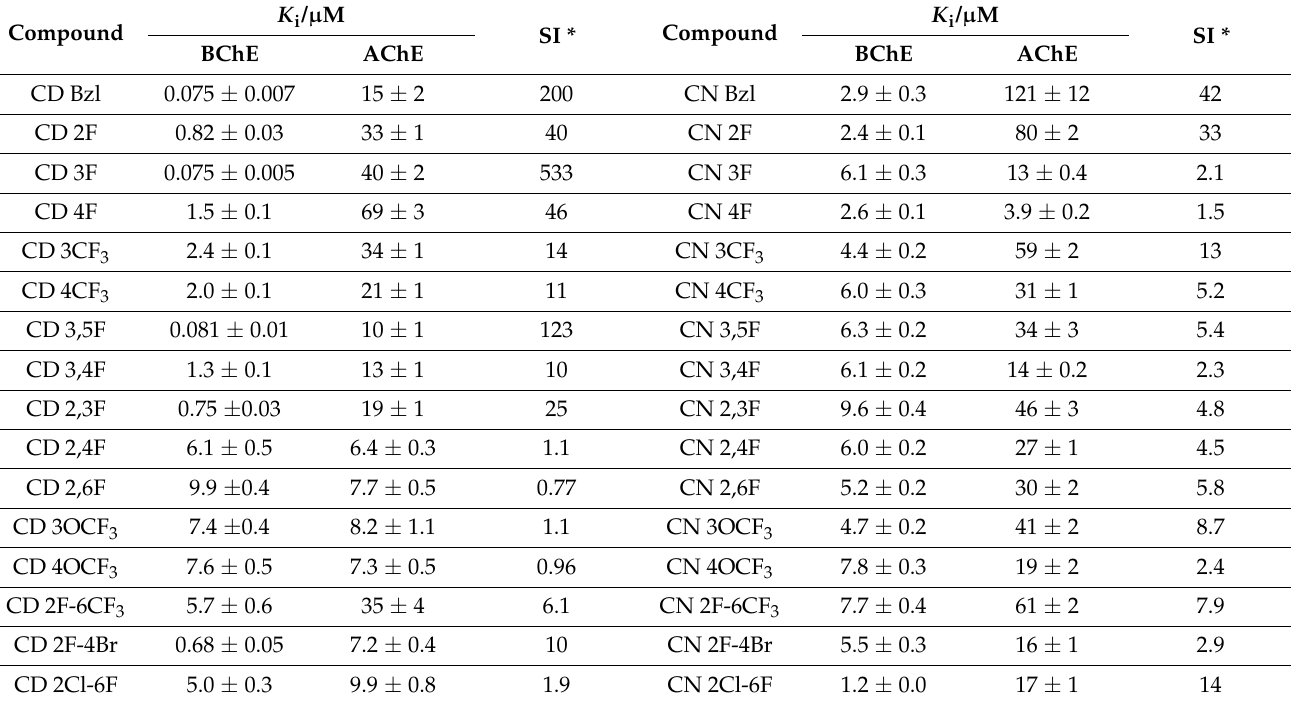
Table 1. Inhibition of AChE and BChE by derivatives of cinchonine and